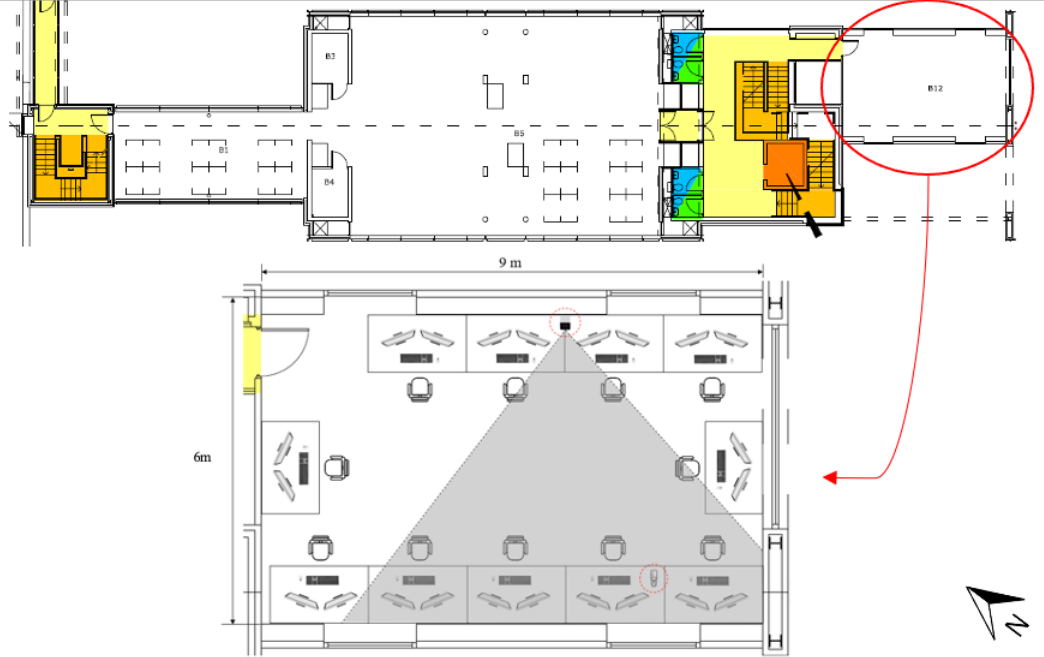
Figure 5. Selected office space (Room B12) floor plan with the experimental setup for the test room.